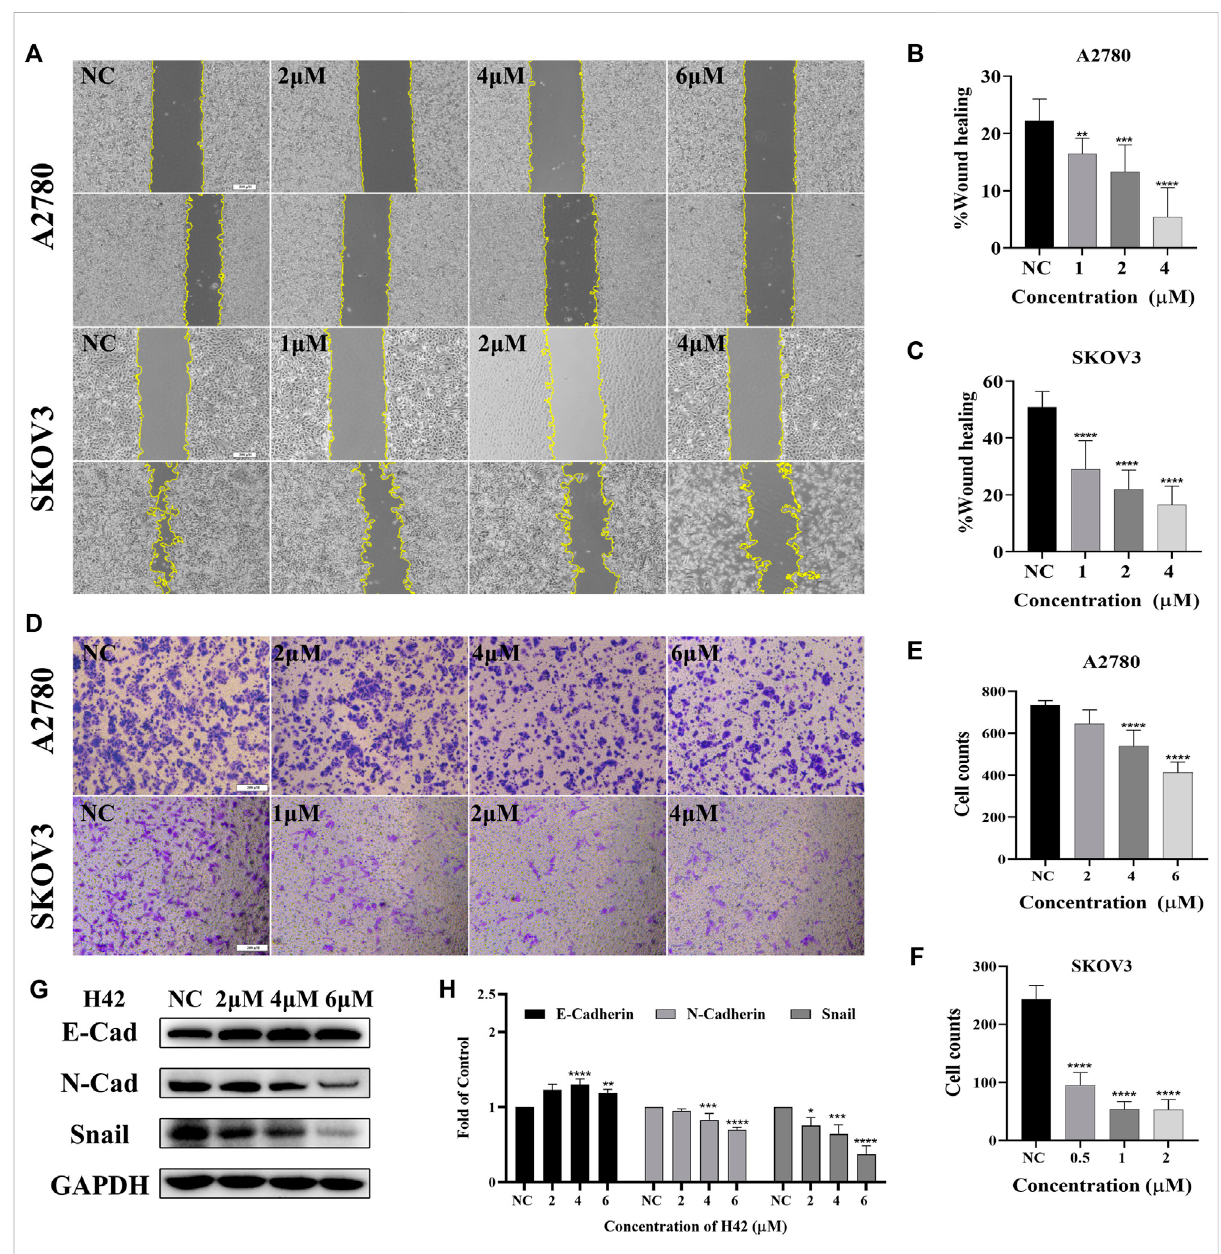
CompoundH42inhibitedmigrationofovariancancercells. (A – C) ThemigrationofA2780andSKOV3cellstreatedwithvariousconcentrations of H42 was determined by wound healing assay. (D – F) Migration of A2780 and SKOV3 cells treated with various concentrations of H42 was determinedbytranswellassay.( G )Expressionofmigration-relatedproteinsinA2780cellswasmeasuredbyWesternblotandanalyzedinthedensity ratio ( H ). Data are represented as mean ± SD of at least three independent experiments. * p < 0.05, ** p < 0.01, *** p < 0.001, and **** p < 0.0001 were compared with the